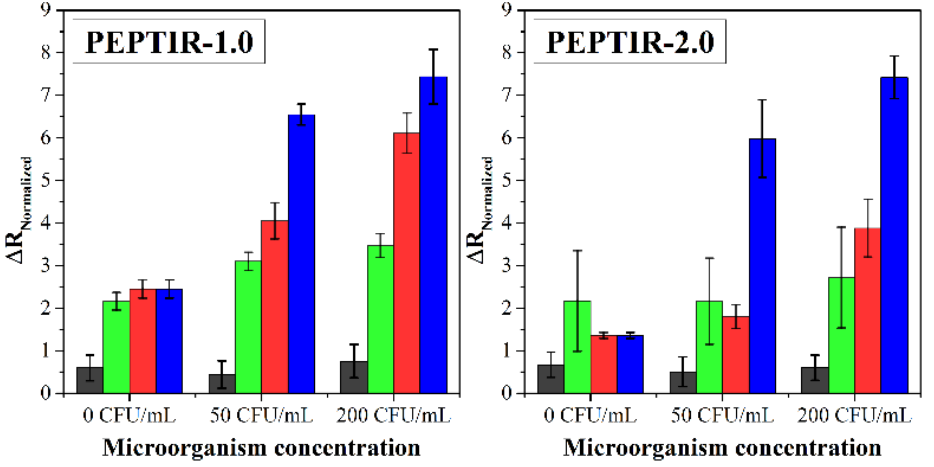
Figure 5. Effect of different concentrations of bacteria on the electrochemical response of the biosen- sors prepared. Aqueous matrix doped with Pseudomonas aeruginosa (gray bars), Staphylococcus aureus (green bars), E. coli ATCC 25922 (red bars), and E. coli O157:H7 (blue